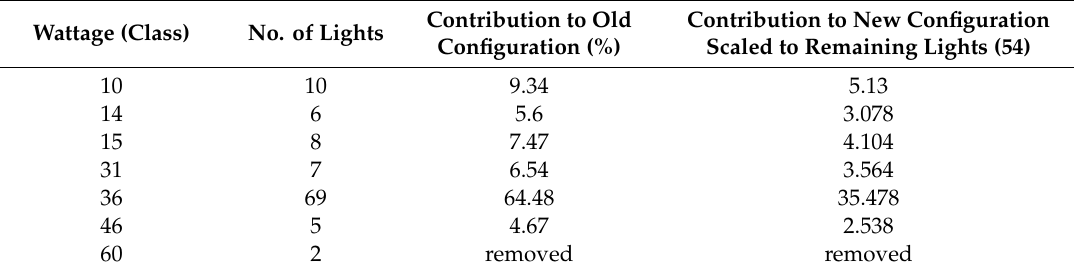
Table 2. Discovery of applicability